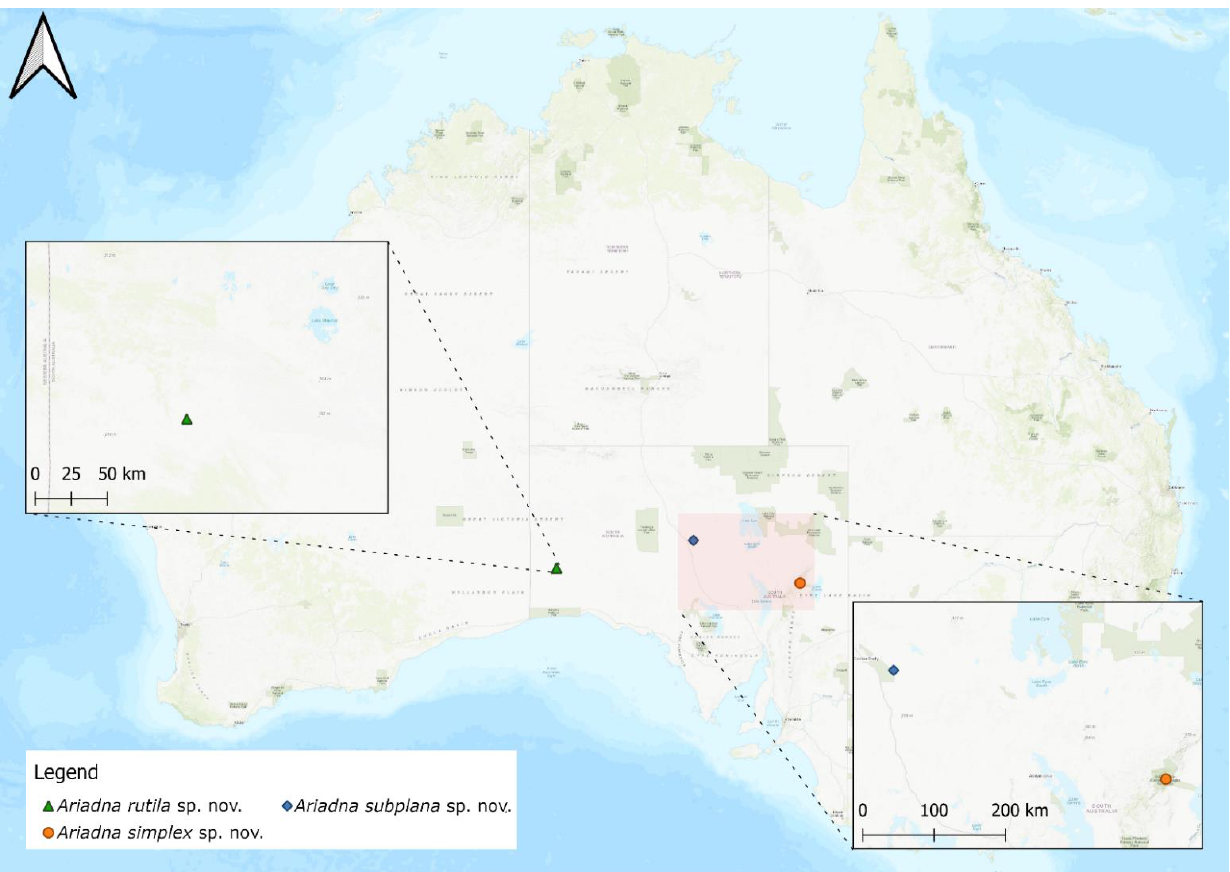
Figure 52. Map showing the currently known distribution of A. rutila sp. nov., A. simplex sp. nov., A. subplana sp. nov.